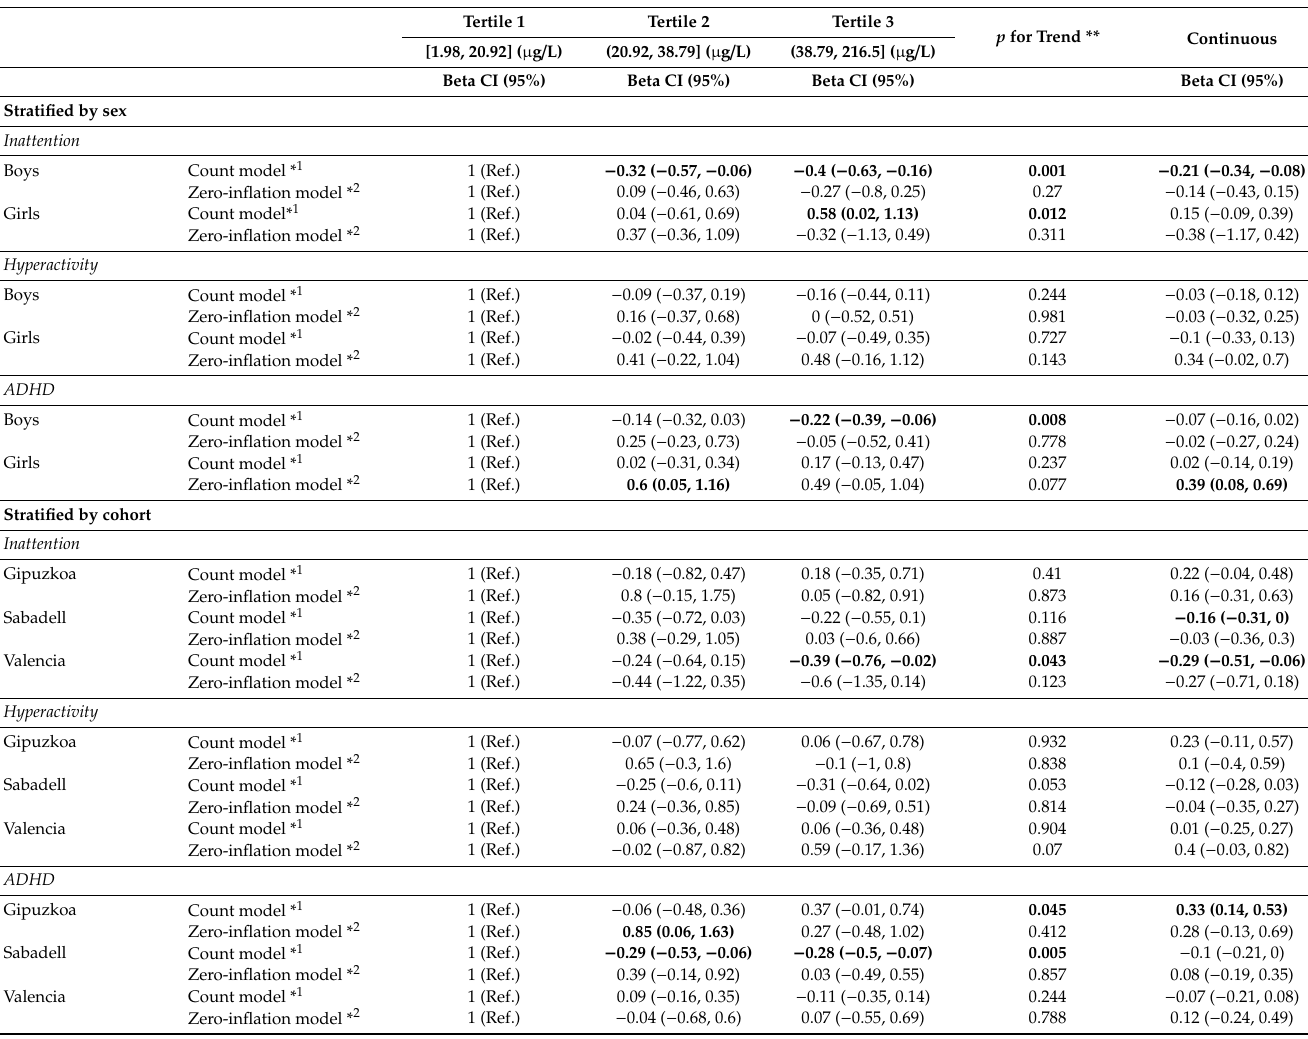
Table 4. Zero-inflated Poisson regression models for the association between inattention, hyperactivity and ADHD symptoms with ferritin levels (log